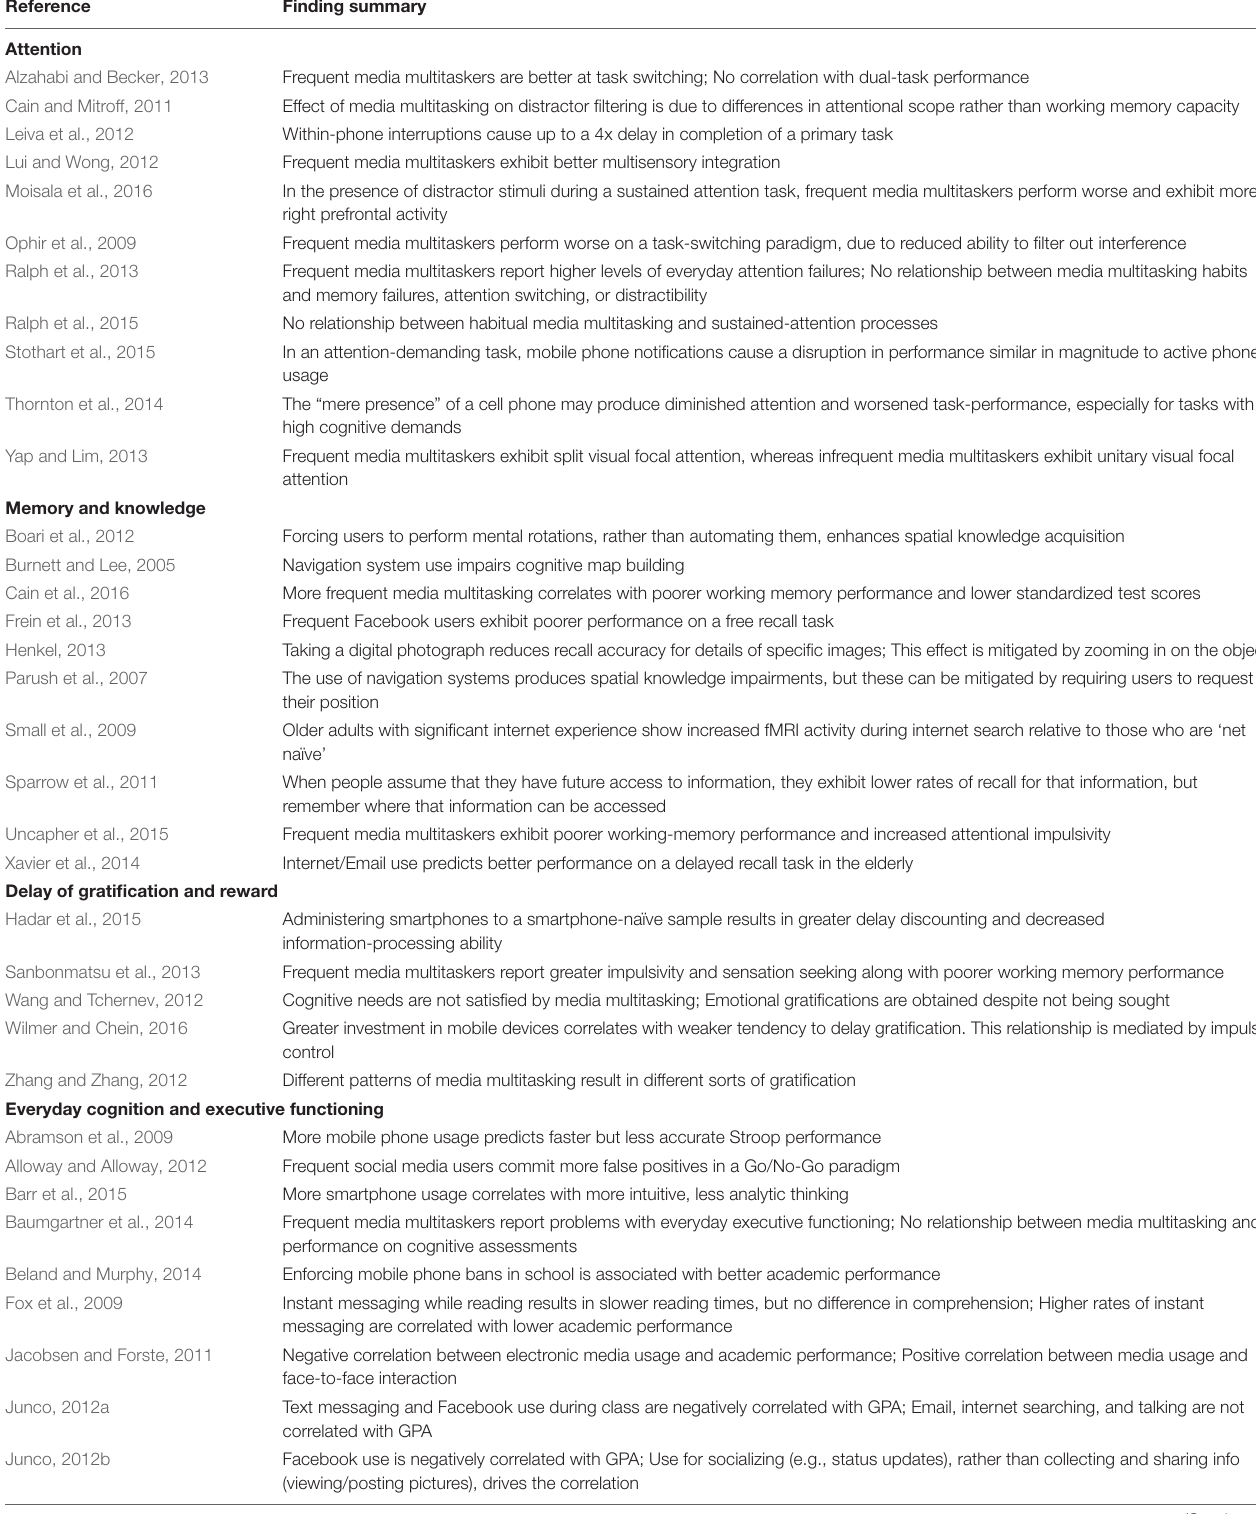
TABLE 1 | Representative publications exploring associations between technology usage and cognitive domains.